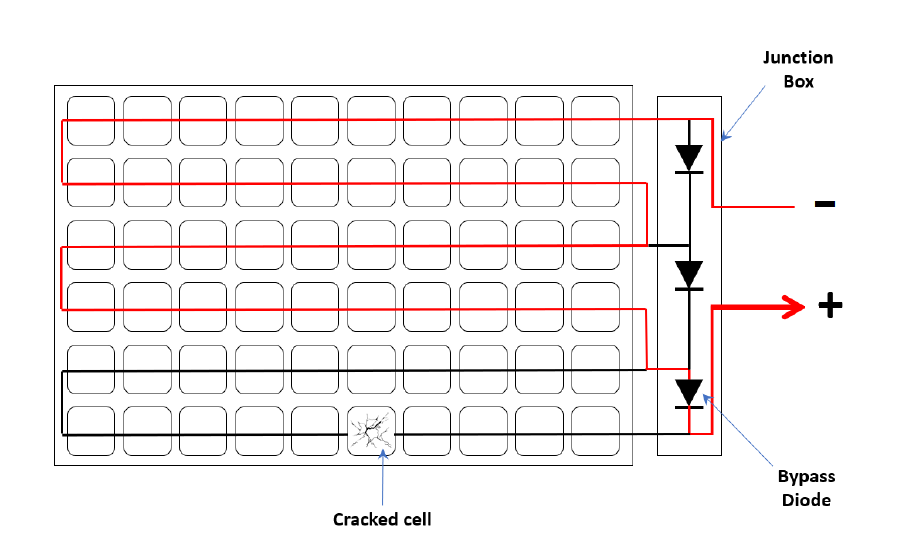
Figure 14. Bypassed cells due to